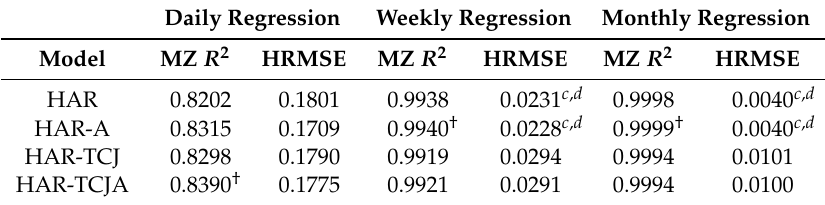
Table 9. Out-of-sample forecast evaluation for minimum variance portfolio